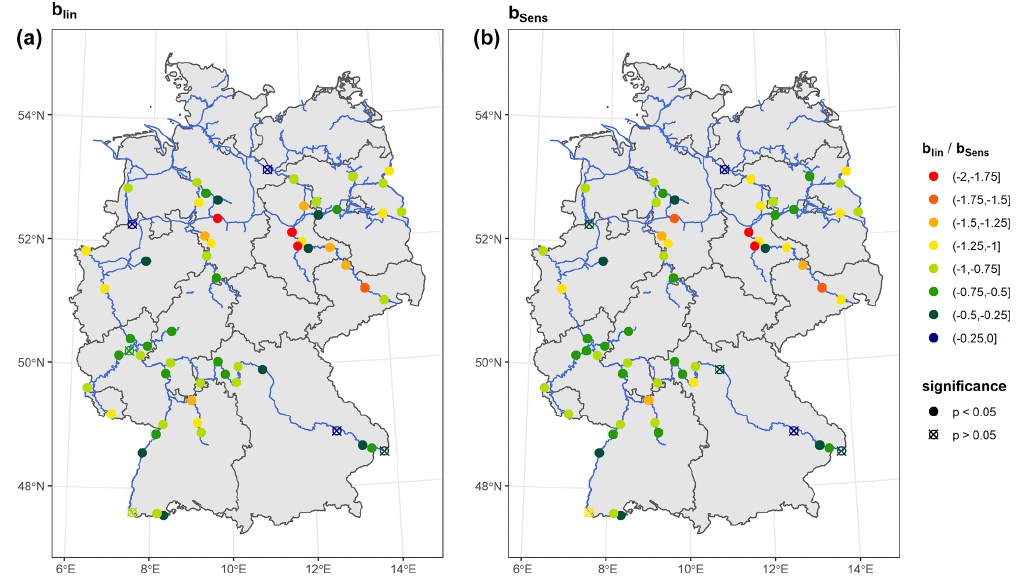
Figure 3. Spatial distribution of trends of annual average SSC (in mgL − 1 yr − 1 ) between 1990 and 2010 along the waterways in Germany. Panel (a) shows trend magnitudes derived from linear regression, and panel (b) shows trend magnitudes derived from Sen’s slopes.